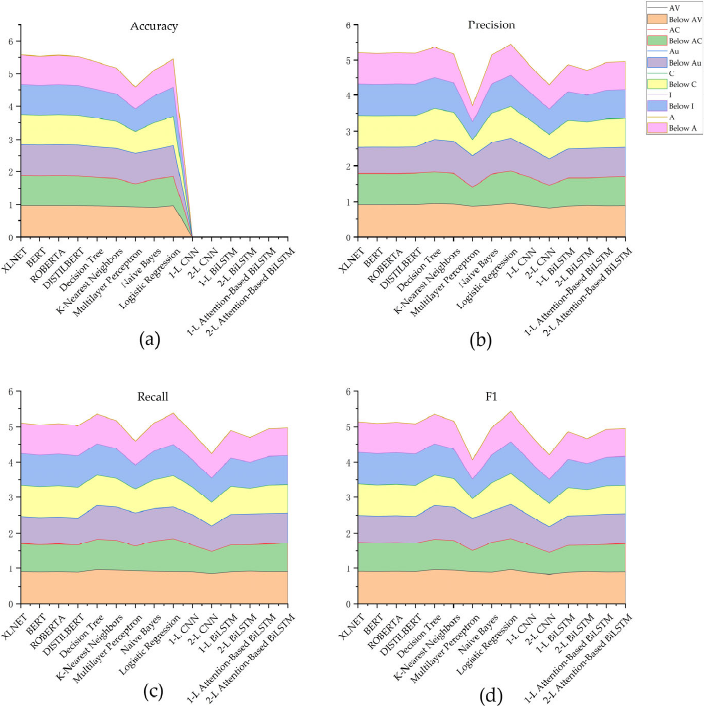
Figure 7. Performance comparison of XLNet with other algorithms on the CVSS v2 dataset. ( a ) Eval ‐ uation metric: accuracy; ( b ) evaluation metric: precision; ( c ) evaluation metric: recall; ( d ) evaluation metric: F1 ‐ score.